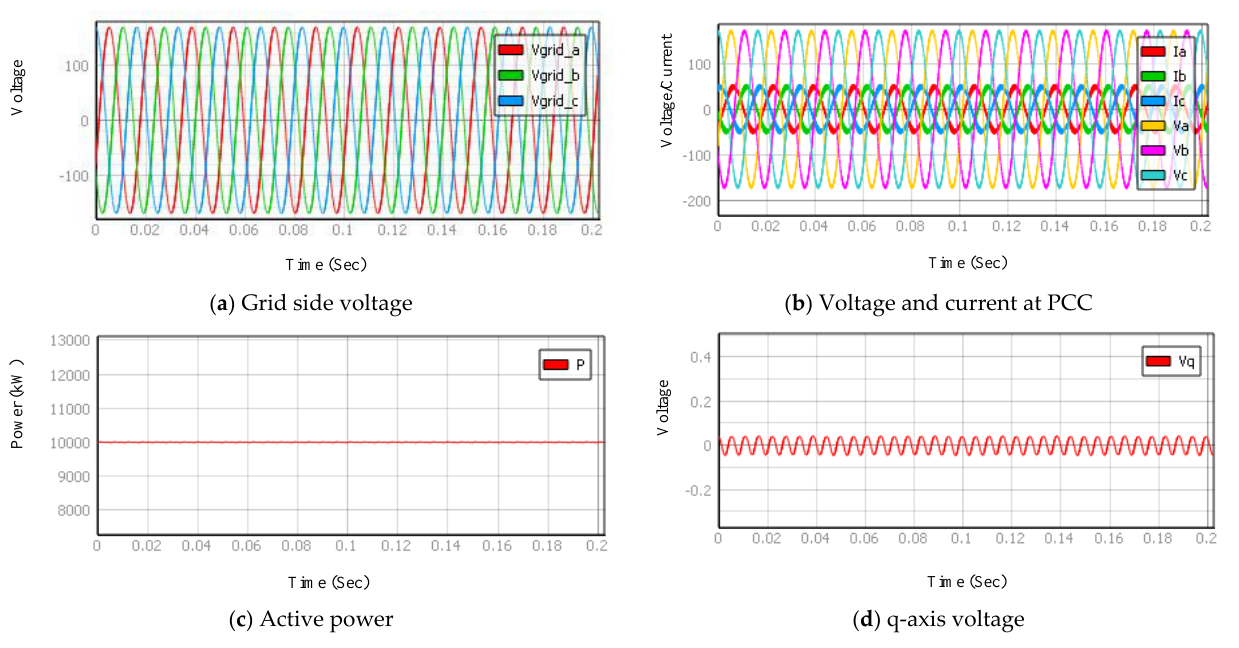
Figure 14. Characteristics of the grid-connected DG system.